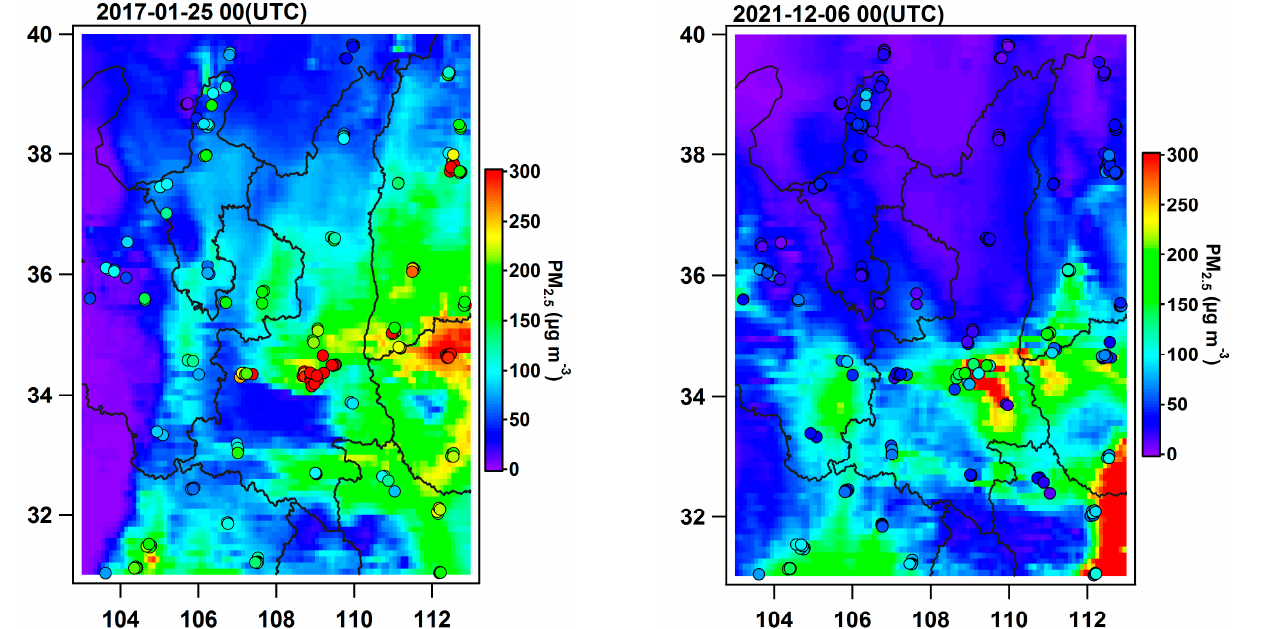
Figure 8. The PM 2.5 concentration distribution of 25 January 2017 and 6 December 2021 cases simulated by CMA − CUACE (the soild dots represent the observed values).